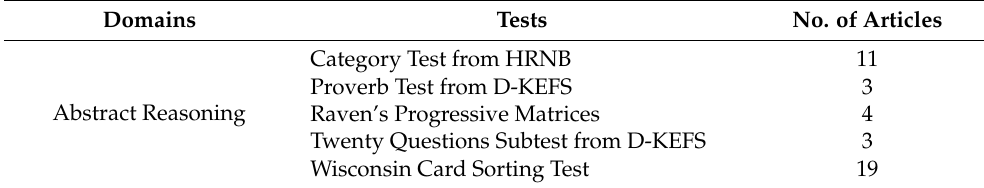
Table 3. Cognitive domains targeted in outcome assessments of coma survivors. Cognitive do- mains are listed alphabetically, along with the number of unique tests used to assess the domain. Tests that appeared in three or more articles are included, along with the total number of articles that included